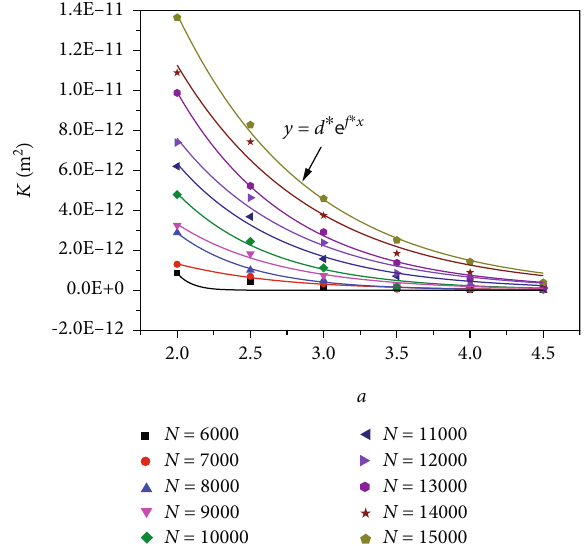
with the number of fractures and a . i